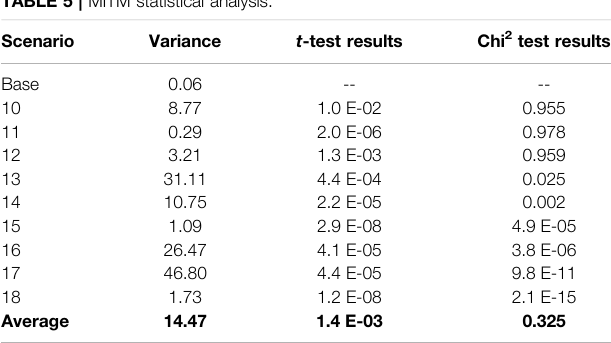
TABLE 5 | MITM statistical